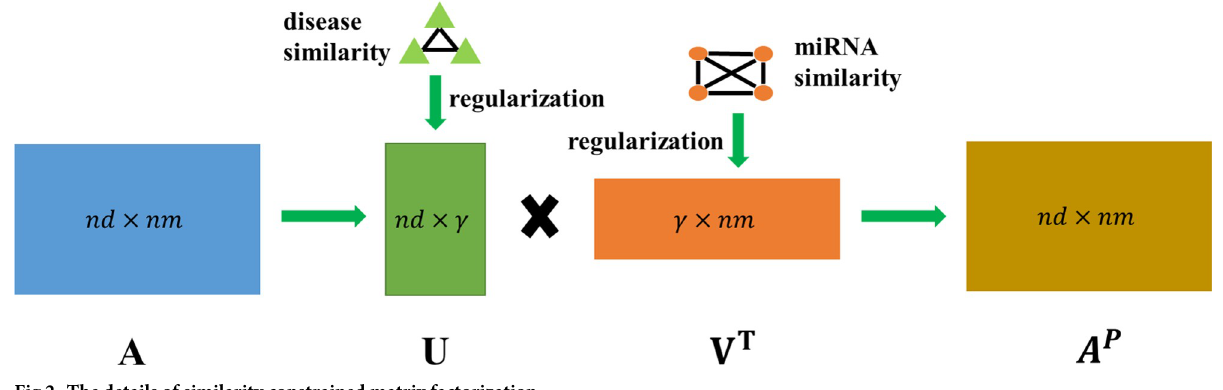
Fig 2. The details of similarity constrained matrix